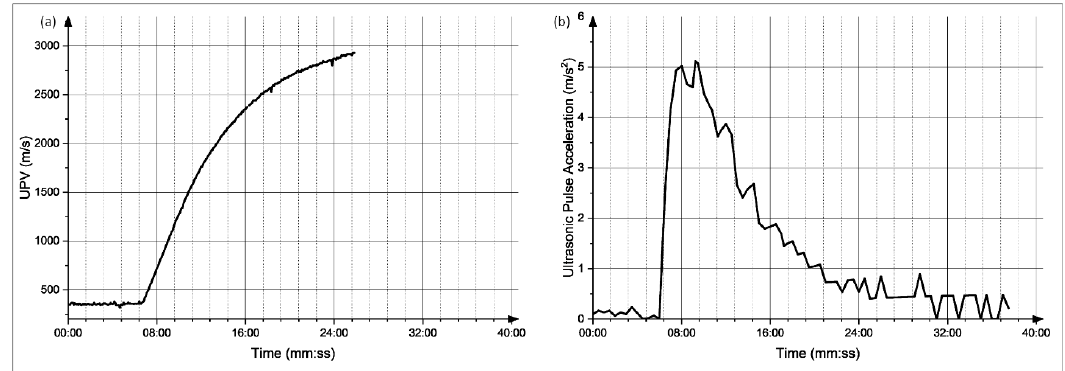
Figure 9. ( a ) Evolution of UPV with time for mix 1. ( b ) Derivative of the UPV graph.